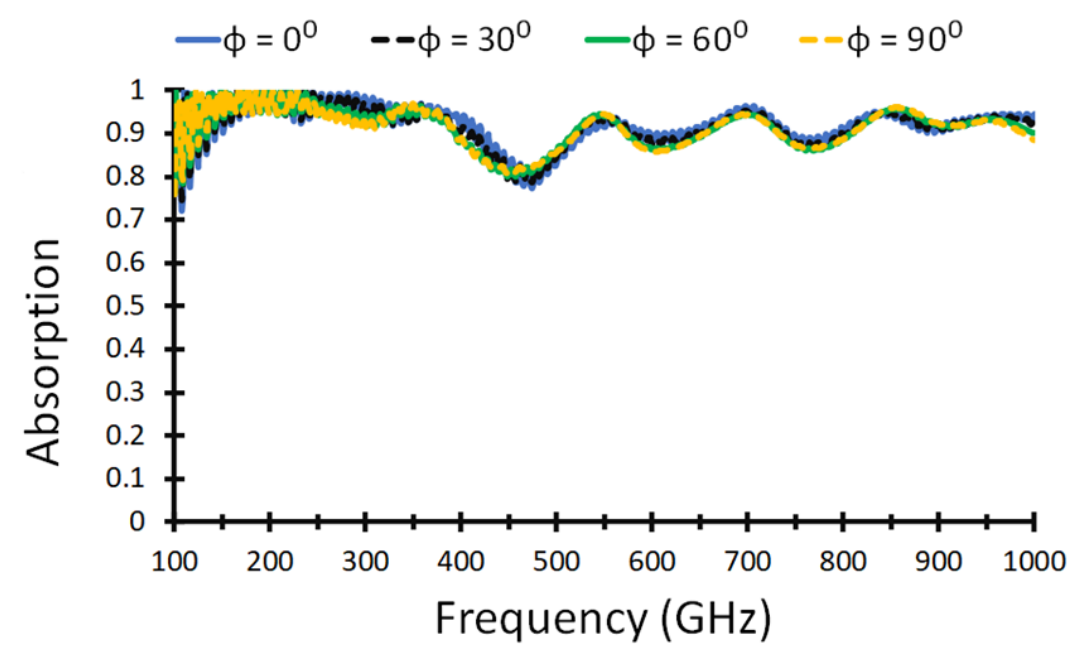
Figure 15. Absorption of the proposed optimized MMA structure for different light polarization at normal incidence.